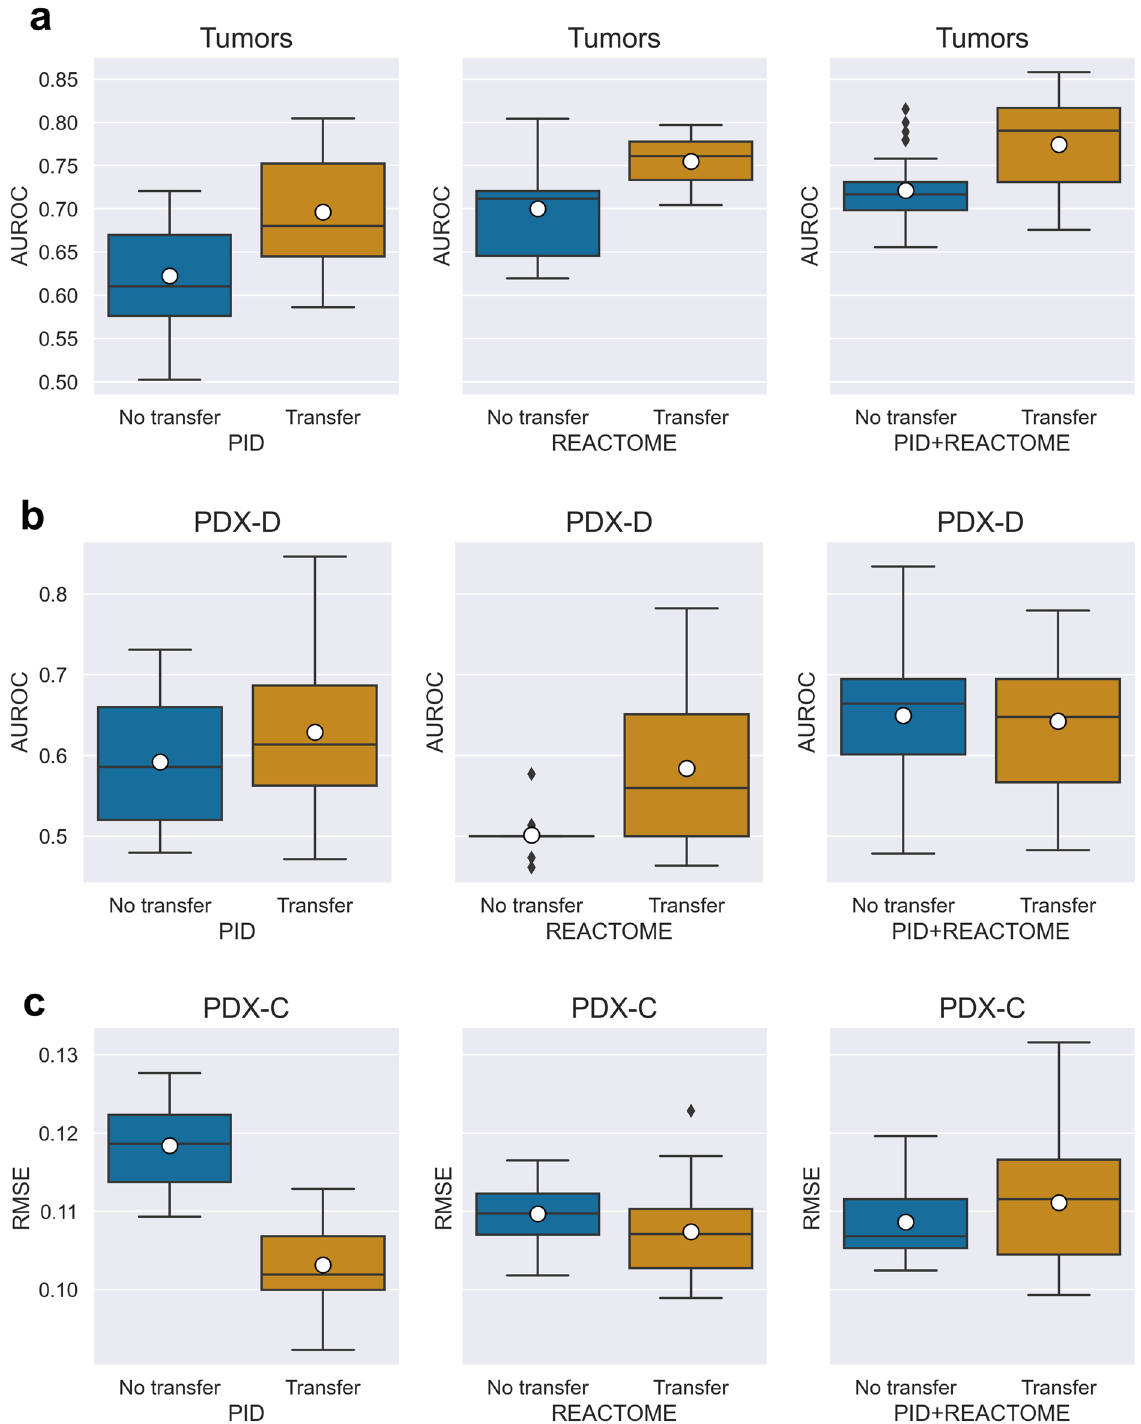
Figure 2. Box plot of performance score distribution across repetitions of cross validation. Brown boxes are transfer learning models, and blue boxes are models without transferred layers (n = 25 scores per model for each box). White circles are mean lines. ( a ) and ( b ) are the Area Under the Receiver Operating Curve (AUROC) for the tumor dataset, and the PDX-D datasets, respectively. ( c ) the Root Mean Squared Error (RMSE) obtained from the PDX-C